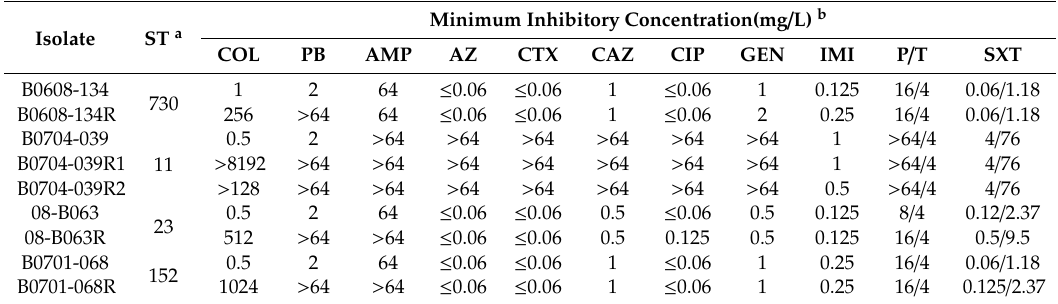
Table 1. Antimicrobial susceptibility profiles in four pairs of isogenic Klebsiella pneumoniae strains.